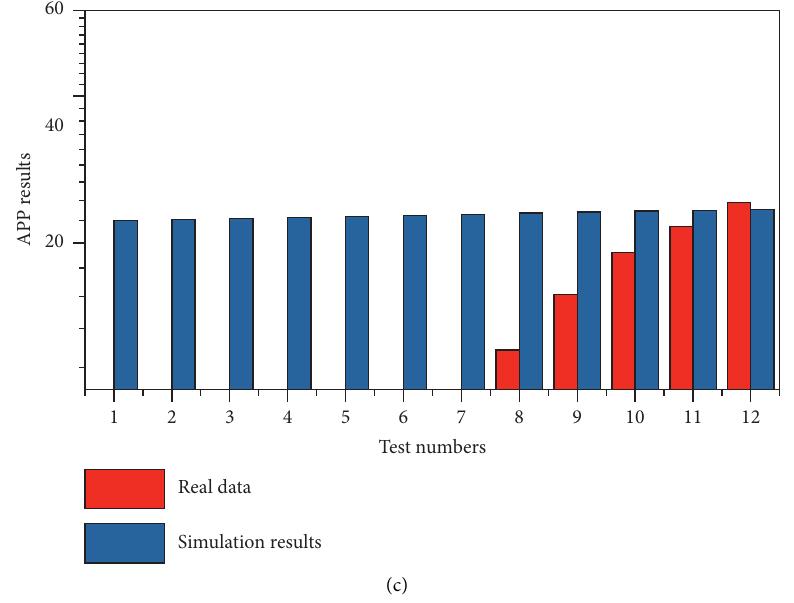
Figure 7: Modeling results table for business X .